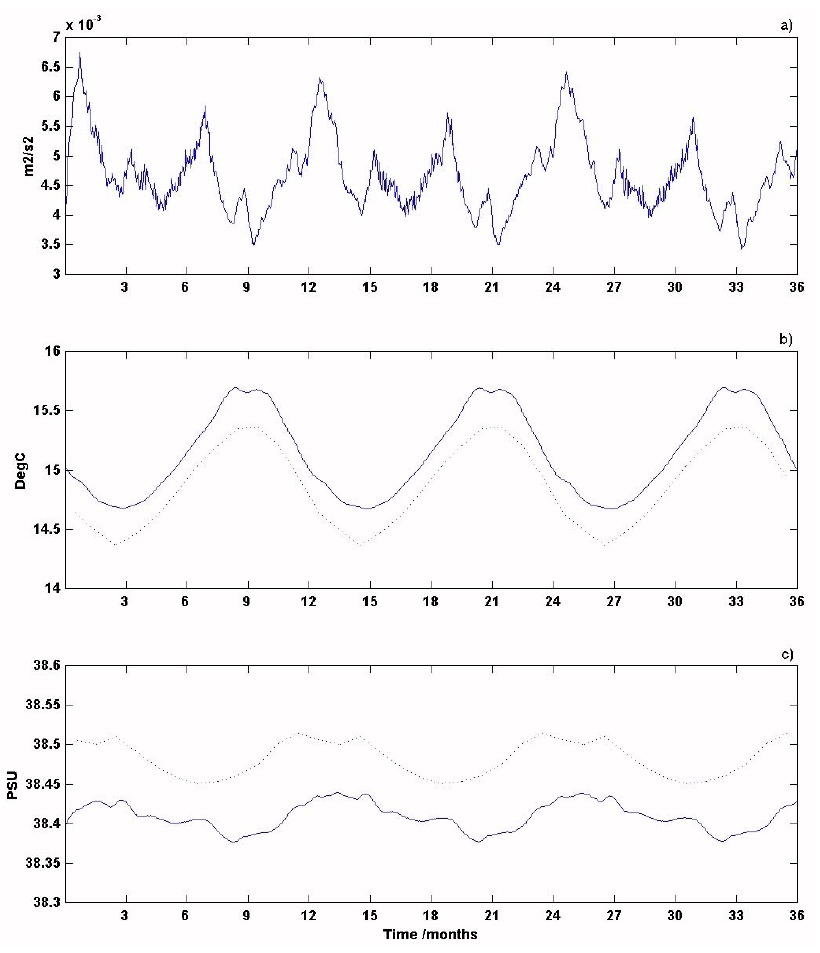
Fig. 5. Time series of (a) basin aver- aged kinetic energy, (b) basin mean po- tential temperature, and (c) basin mean salinity. The solid line represents the modelled values, while the dashed line represents the monthly climatological values plotted on the 15th day of the